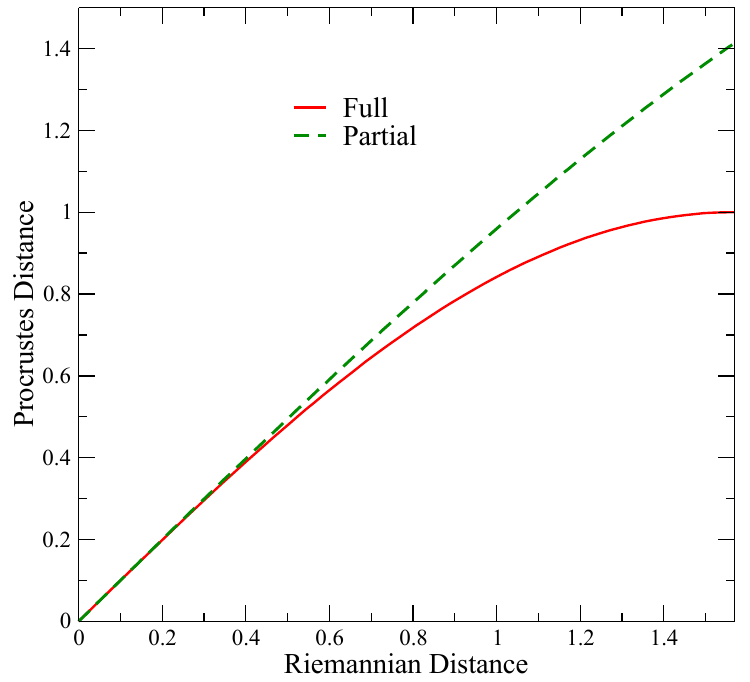
Figure 3. Relation between the Riemannian distance and the Procrustes distances (Full and Partial). The three distances behave similar in presence of BA products close to reference data (LANDSAT).